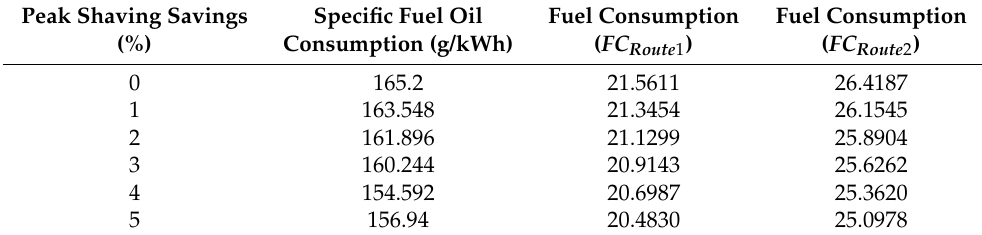
Table 10. Specific fuel oil consumption after peak